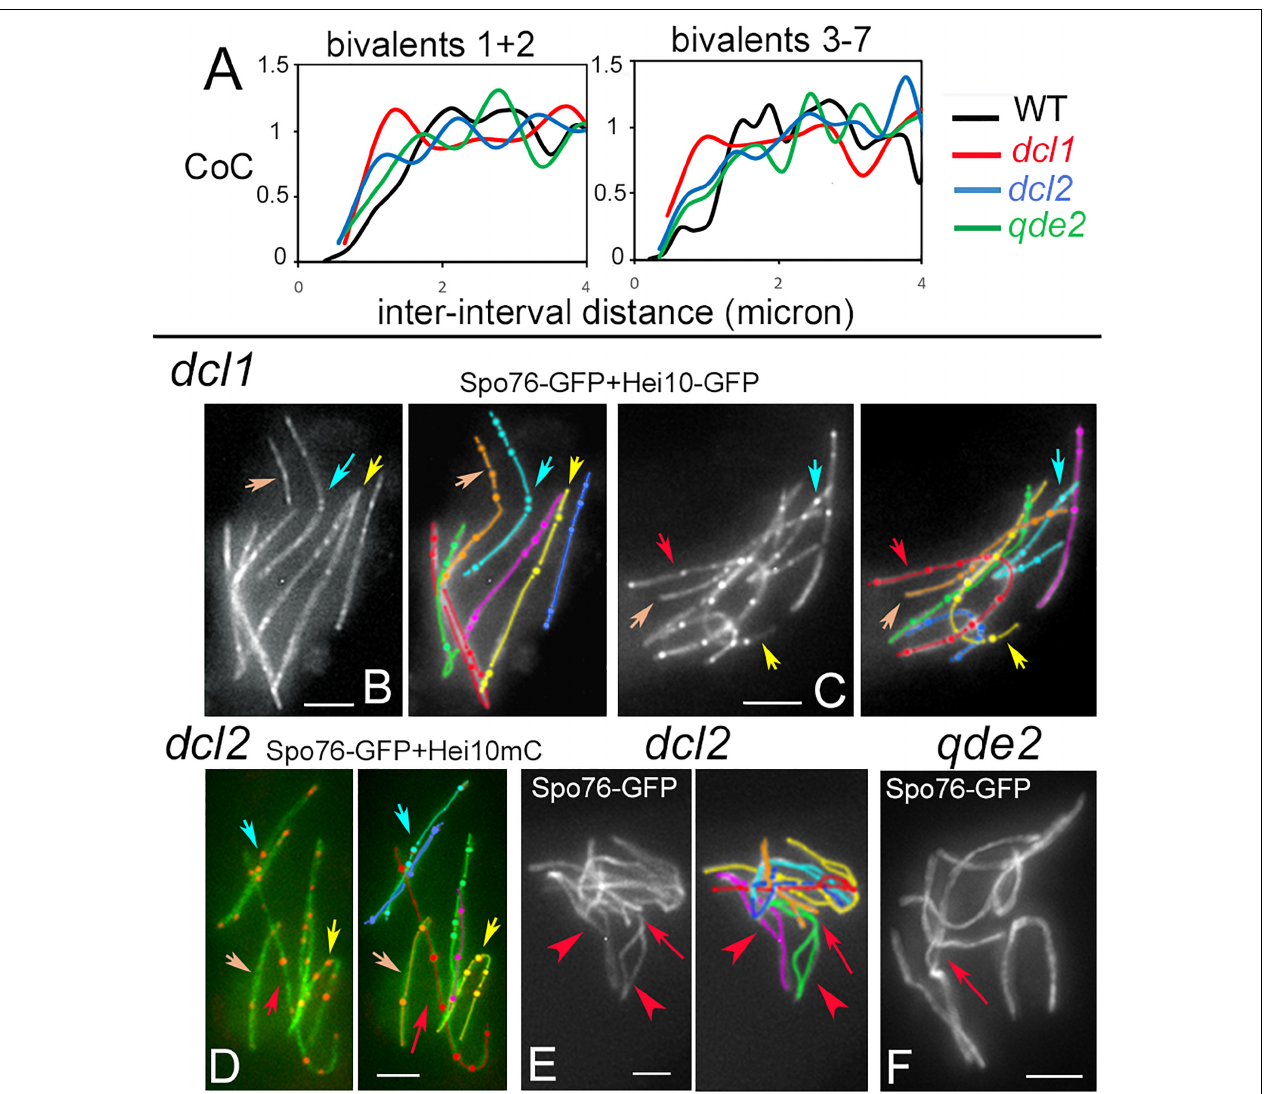
FIGURE 5 | Crossover interference, patterns and synapsis defects in dcl1 , dcl2, and qde2 . (A) Coefficient of Coincidence (CoC) plotted as a function of inter-interval distances in longer homologs 1 and 2 (left) and shorter homologs 3 to 7 (right) of WT, dcl1 , dcl2, and qde2 . (B,C) Hei10 foci along homologs in dcl1 early (B) and mid-pachytene (C) nuclei. Note that foci are brighter at the later stage (C) . Similar irregularities in focus distances are seen in dcl1 ( arrows in B,C) and dcl2 (D , arrows ) . Only 4 of the 7 homologs are pointed by arrows for easy lecture, but the other homologs (e.g., the purple and green ones) show also variable distances and close foci. (E) Zygotene nucleus of dcl2 . Note the widely open non-synapsed regions (arrowheads on green and purple homologs) and the resolving entanglement (arrow) between the green and orange homologs (open ends of the orange homolog will help the green homolog to slide out of the interlock). (F) Illustration of a non-resolved interlock at mid-late pachytene (by ascus size) in qde2 (arrow). Bars, 2 µ m.